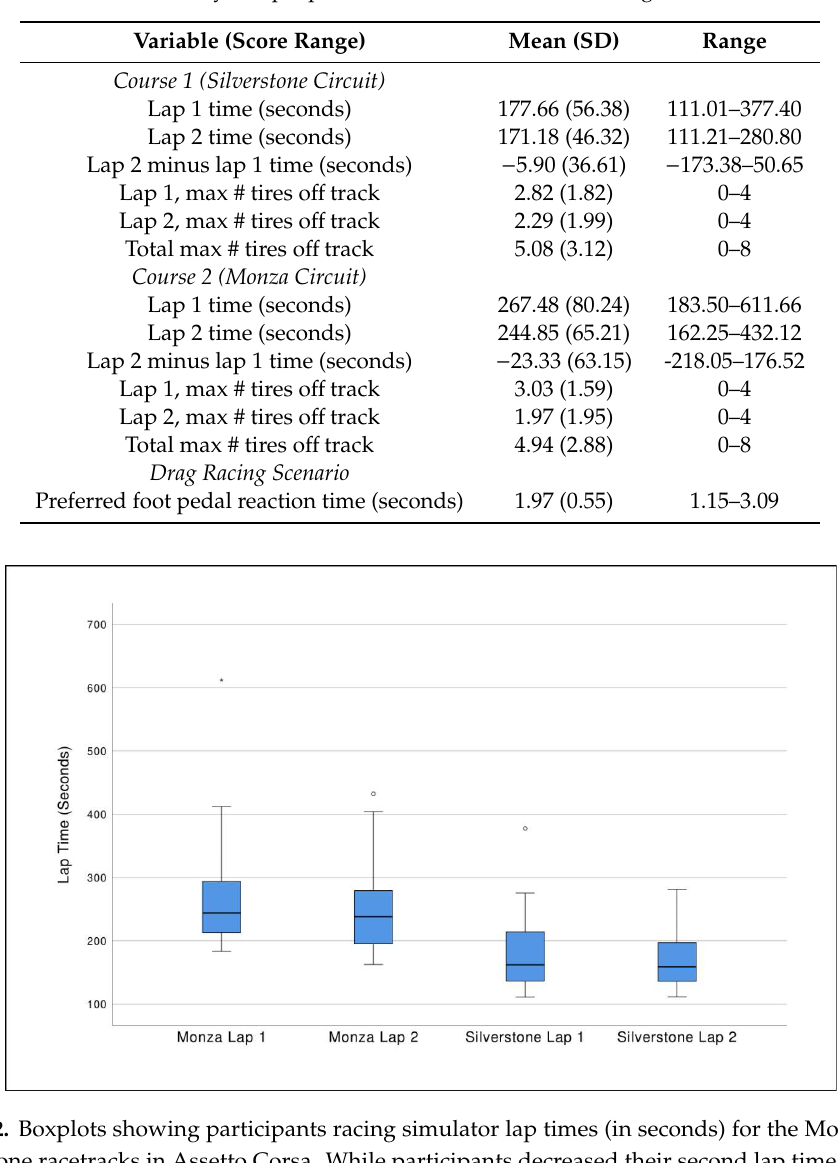
) denotes an outlier (cid:35)